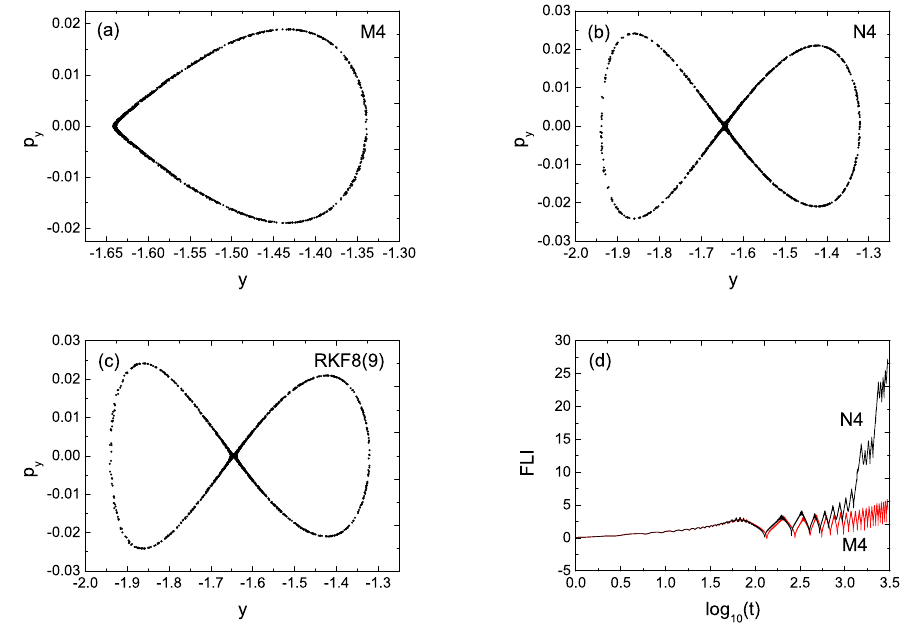
Figure 5. Same as Figure 4 but for different initial values y = − 1.654 and p x . ( a ): Regular single torus. ( b , c ): Figure-eight orbits seem to be regular, but are chaotic, as shown by the FLIs in ( d ). The regularity for M4 in panels ( a , d ) is spurious, but the chaoticity for N4 is physical because N4 provides more accurate numerical solutions than